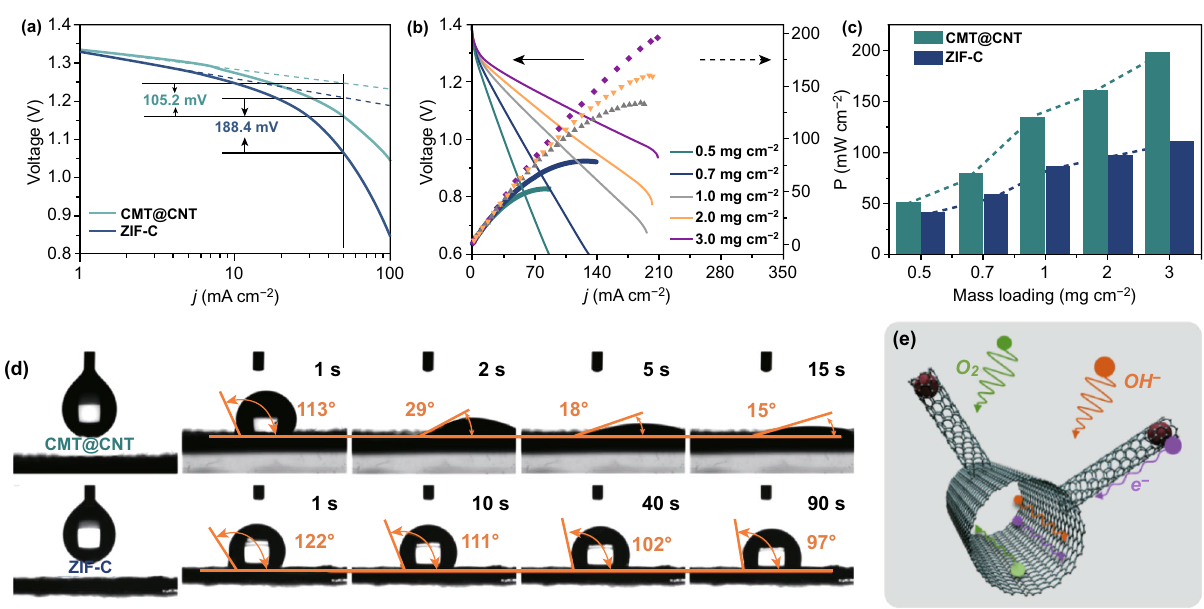
Fig. 6 a Tafel slopes of discharge polarization curves for CMT@CNT and ZIF-C. b Discharge polarization curves and the corresponding power density plots of CMT@CNT-based ZAB at different catalyst mass loading. c Comparison of power density for CMT@CNT and ZIF-C. d Water contact of CMT@CNT and ZIF-C. e Schematic illustration of mass transfer process for